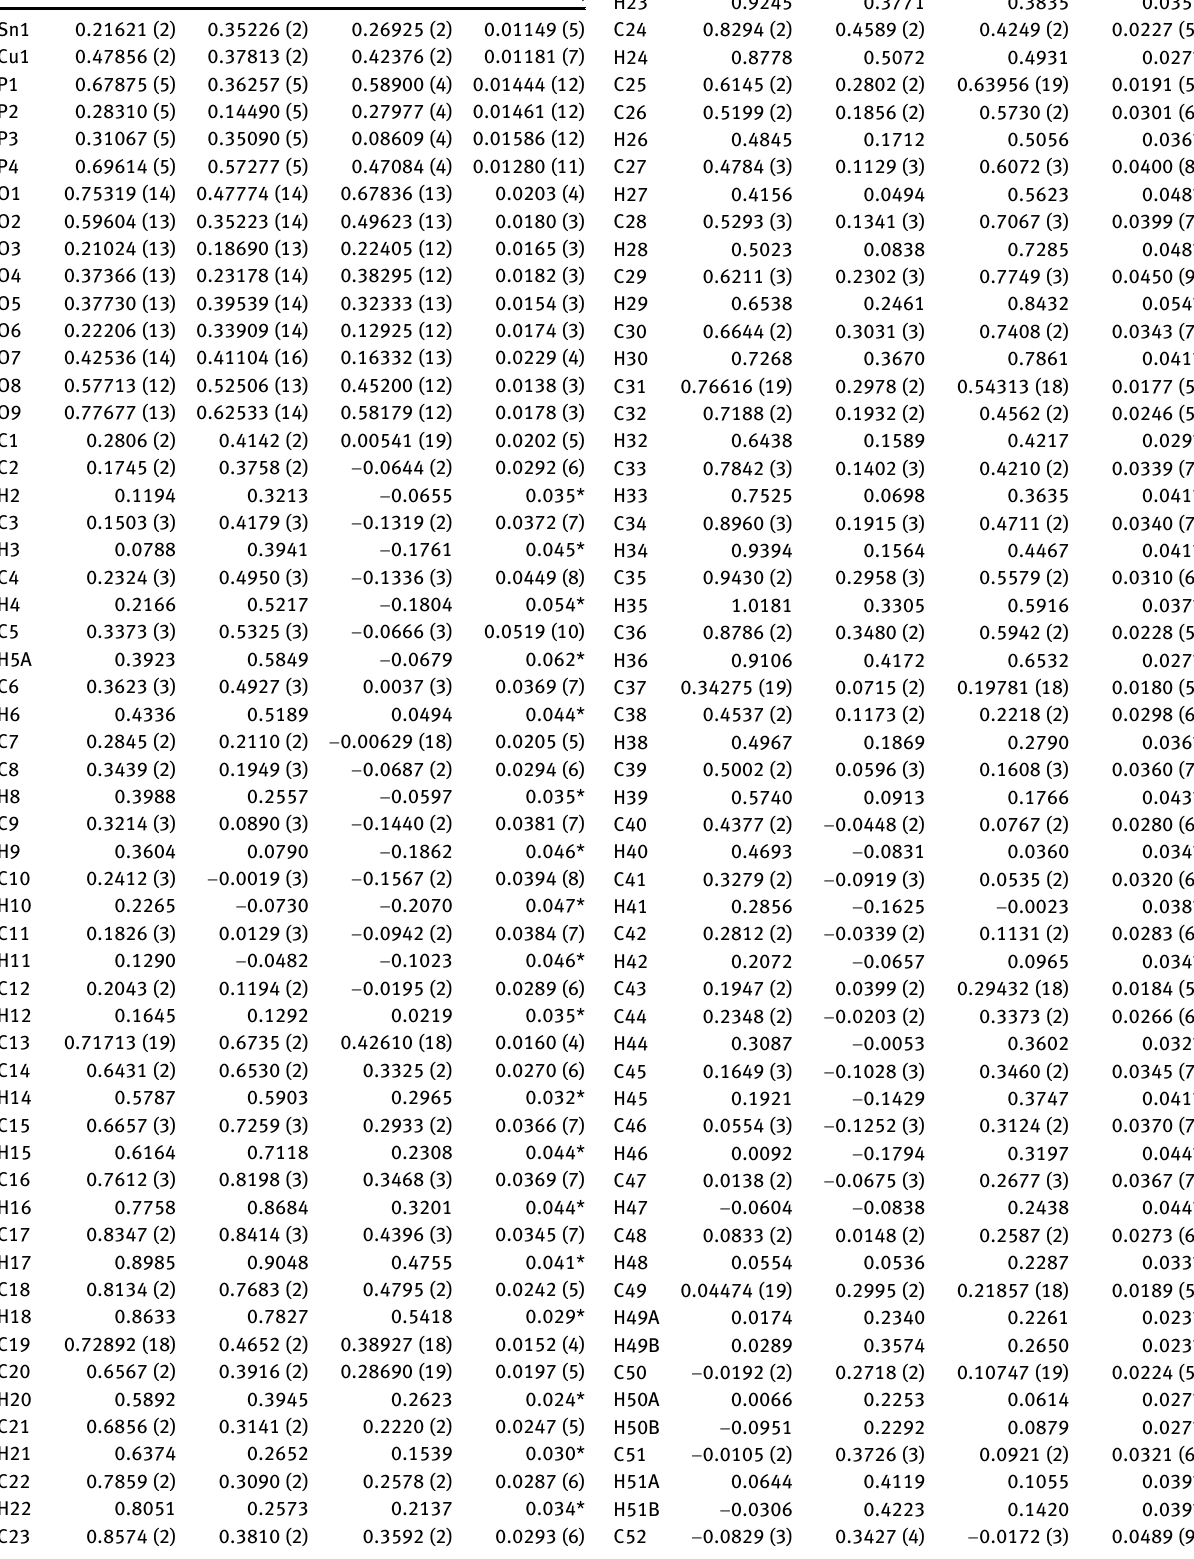
Table  : Fractional atomic coordinates and isotropic or equivalent isotropic displacement parameters (Å 